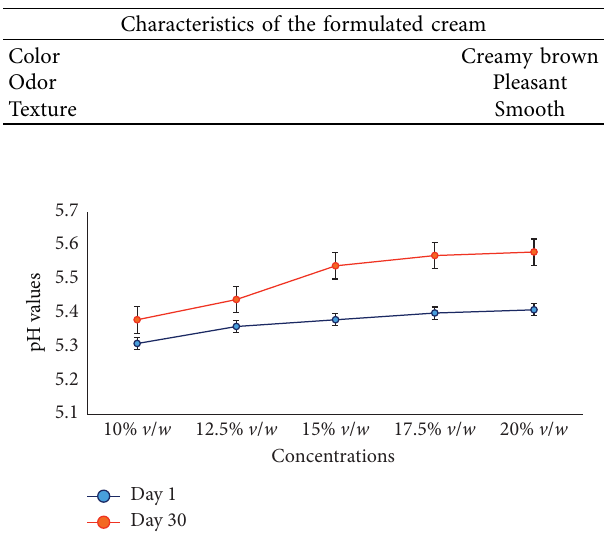
Figure 1: pH of different concentrations of neem seed oil cream on